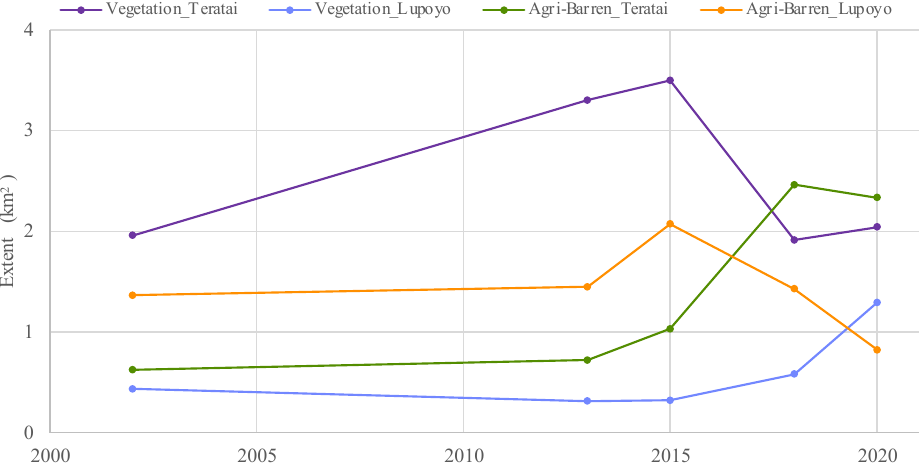
Figure 4. Land cover classification of vegetation and lands/barren in Teratai and Lupoyo